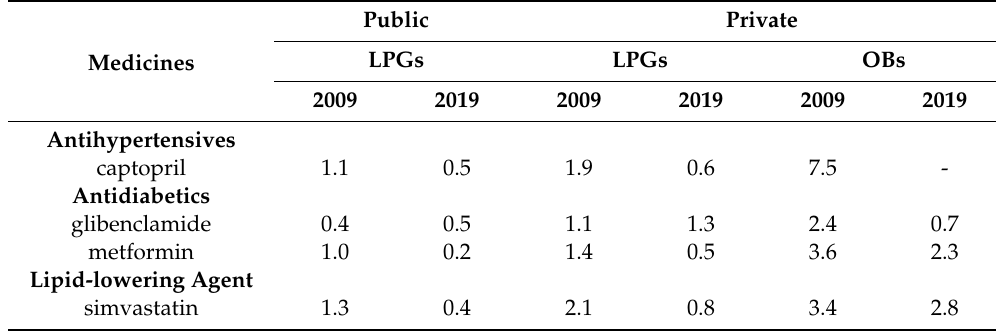
Table A4. Comparison of a ff ordability of medicines in the